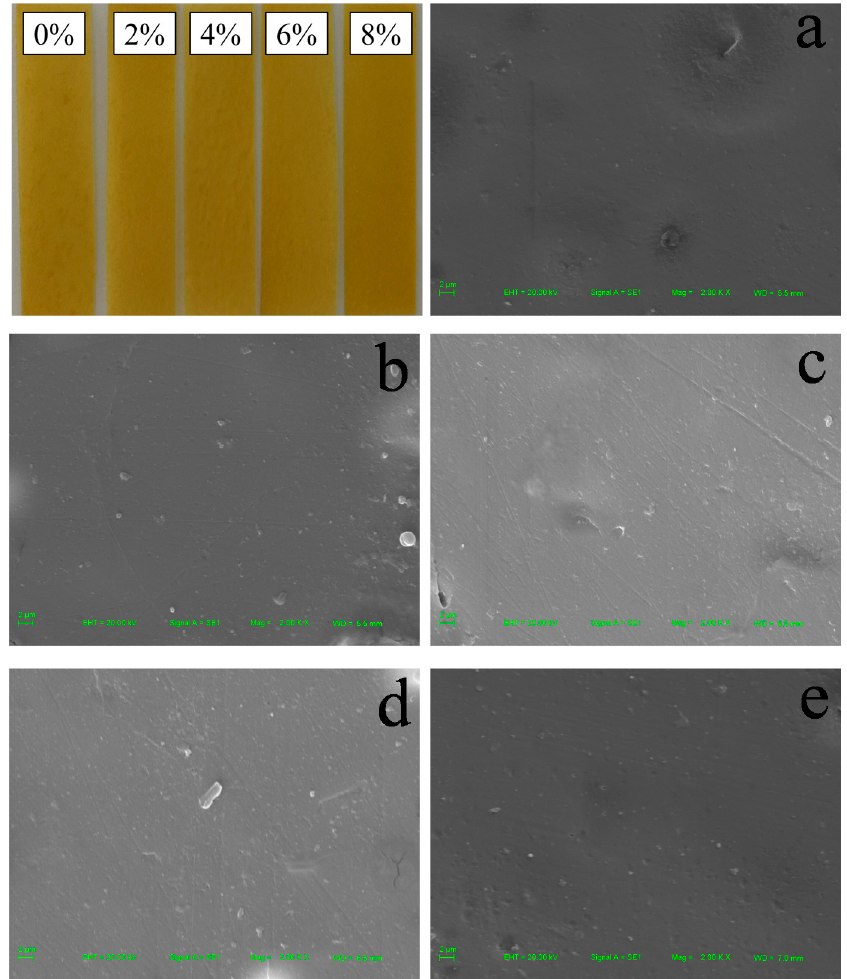
Figure 1. Physical appearances and SEM images of Zein/NPs ( a ), Zein/NPs/2CNCs ( b ), Zein/NPs/4CNCs ( c ), Zein/NPs/6CNCs ( d ) and Zein/NPs/8CNCs ( e ).